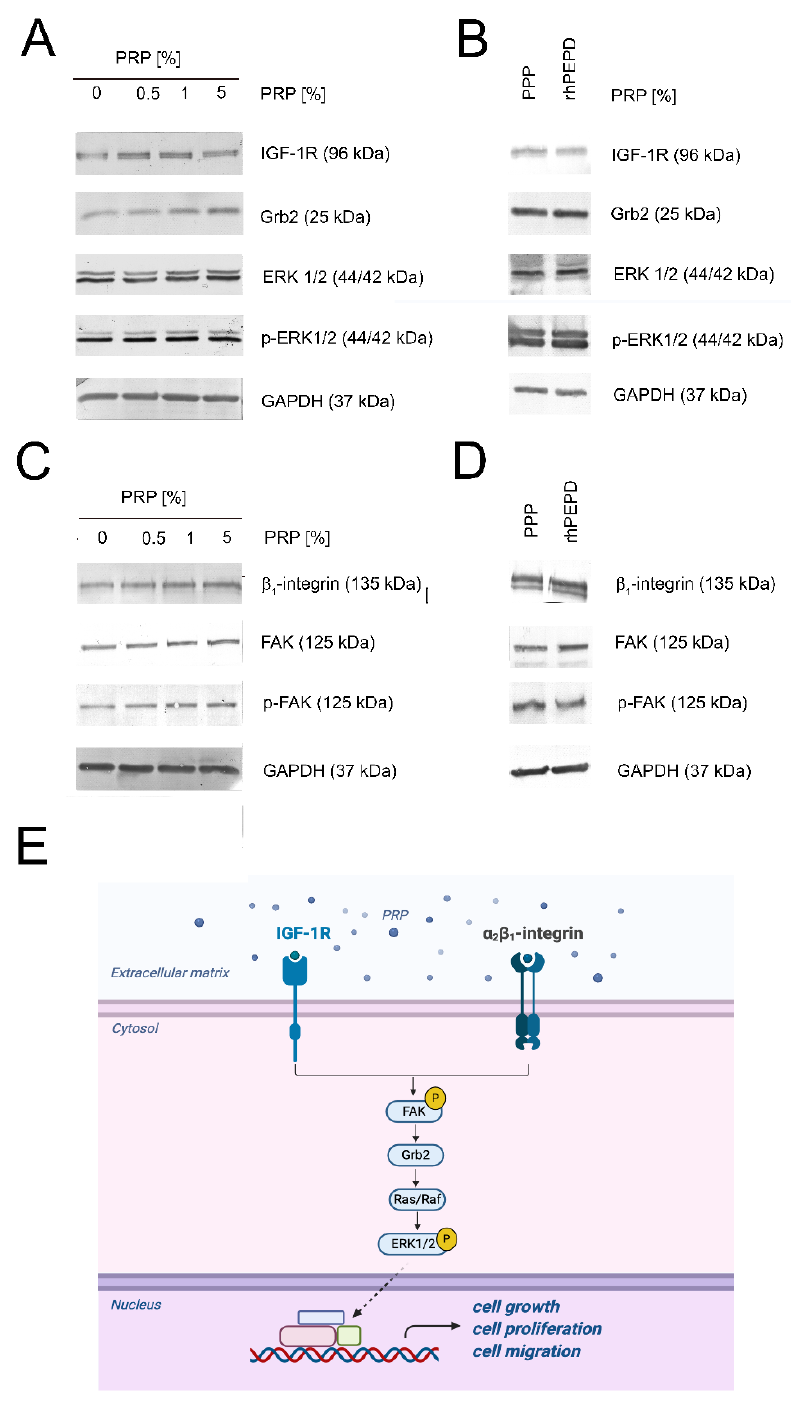
Figure 4. PRP-dependent activation of β 1 -integrin and IGF-1R signaling pathways in HaCaT cells ( A ) PRP-dependent activation of IGF-1R-downstream signaling pathway; ( B ) Western immunoblotting of IGF-1R-downstream signaling in rhPEPD- and PPP-treated keratinocytes; ( C ) β 1 -integrin signaling in human keratinocytes subjected to PRP; ( D ) Western immunoblotting of β 1 -integrin-downstream signaling in rhPEPD- and PPP-treated keratinocytes; ( E ) Illustration of β 1 -integrin and IGF-1R signaling pathways. Created with BioRender.com.